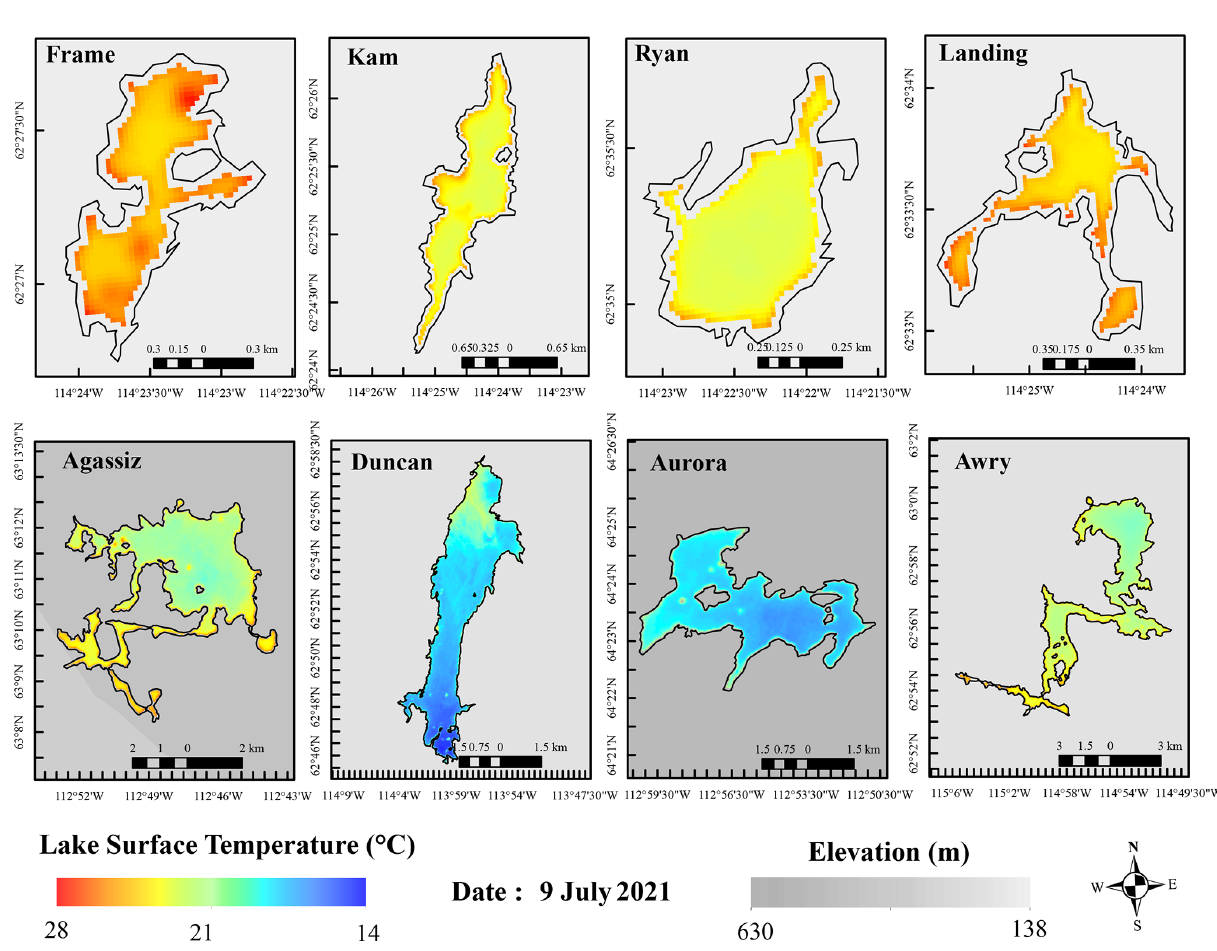
Figure 12. Intra-lake spatial distribution of LST on selected lakes in the NSR highlighting the North Slave LST’s ability to capture small- scale details of the LST.